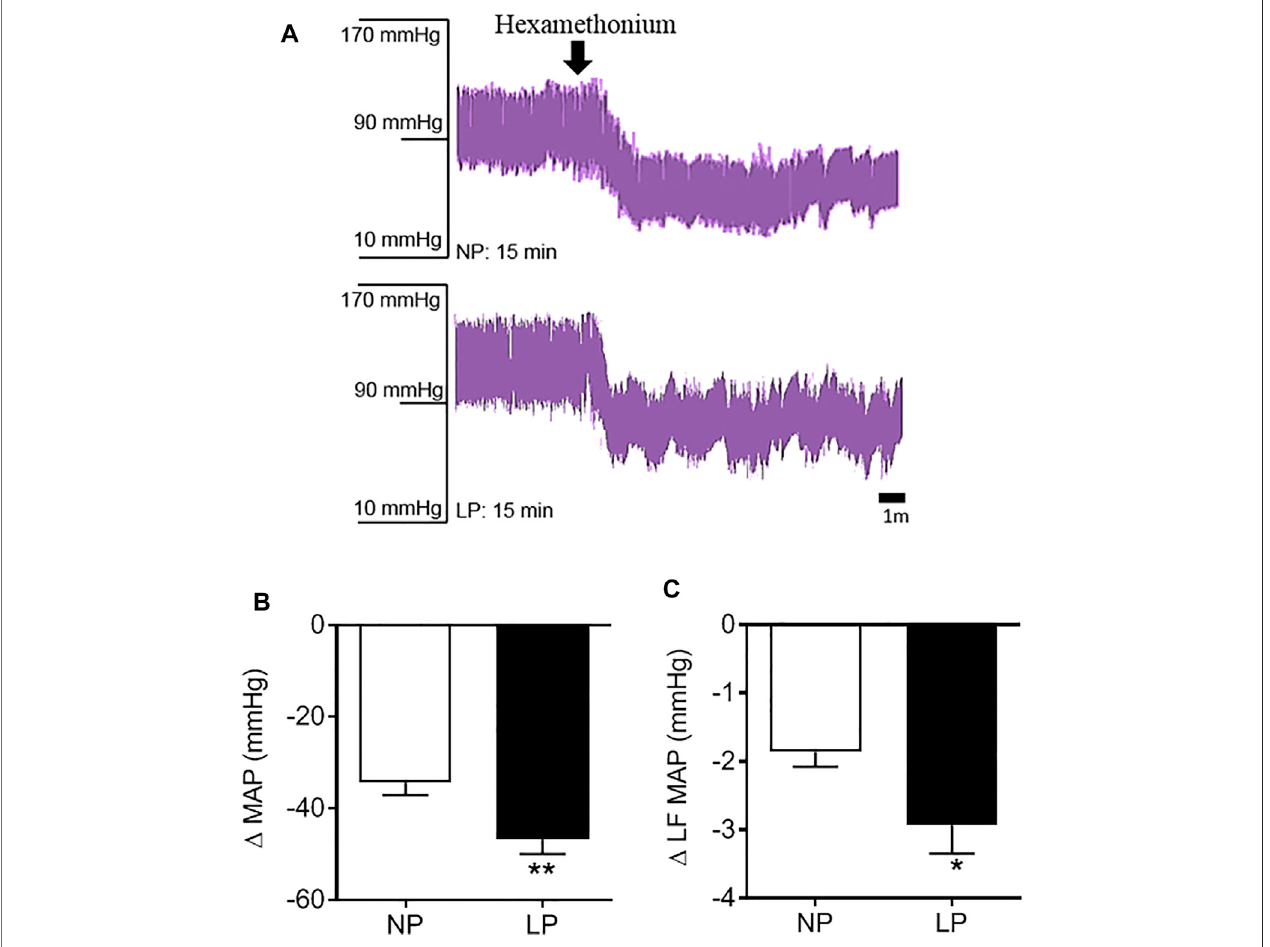
FIGURE 4 | Pressure response to hexamethonium. Representative records of the depressor response to hexamethonium (A) , Change in mean arterial pressure (B) ,andthelowfrequencyzoneofmeanarterialpressureinresponsetohexamethonium (C) , n =10 – 13animalspergroup.NP,normalprotein diet;LP,lowprotein diet. Values presented as mean ± SD *** p < 0.001, ** p < 0.01, and * p < 0.05 indicate statistical signi fi cance (Student ’ s T test).